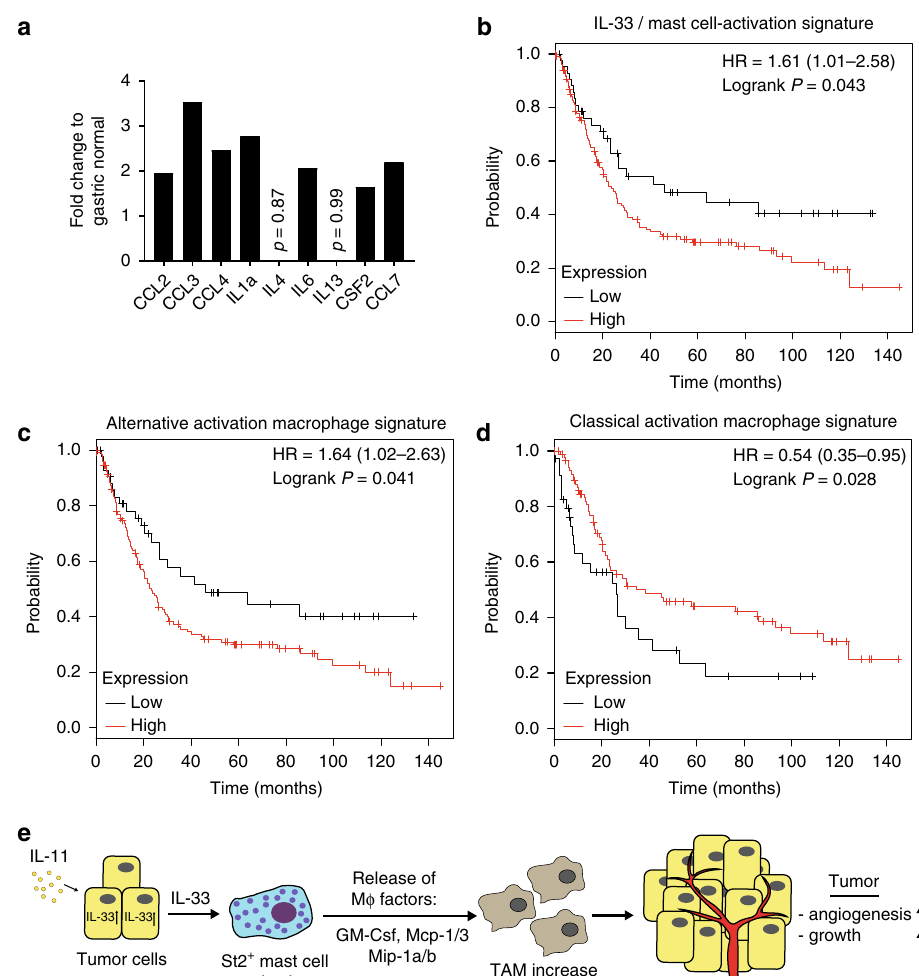
Fig. 8 Kaplan – Meier analysis for an IL-33 - mast cell activation gene expression signature. a Expression analysis of genes associated with IL-33 dependent mast cell activation derived from the DERRICO gastric data set (GEO: GSE13911, extracted from oncomine.org) and comparing normal gastric mucosa ( n = 31) and gastric intestinal-type adenocarcinoma ( n = 29). The p -value for the genes is p < 0.05 except where indicated. b – d Kaplan – Meyer survival analysis was performed for human intestinal-type gastric cancer (iGC) with IL-33/ mast cell activation signature consisting of CCL2 , CCL3 , CCL4 , IL1a , IL6 , CSF2 , and CCL7 ( b ), with alternative activation macrophage expression signature ( CD163 , CD204 , MARCO , ARG1 ) ( c ) and classical activation macrophage expression signature ( NOS2A , HLA-DRA , CD80 , CD86 , CD169 ) ( d ). e Schematic illustration of the proposed gastric cancer growth promoting IL-11/IL-33/mast cell/ TAM signaling axis. Source data are provided as a Source Data fi le. See also related Supplementary Fig.